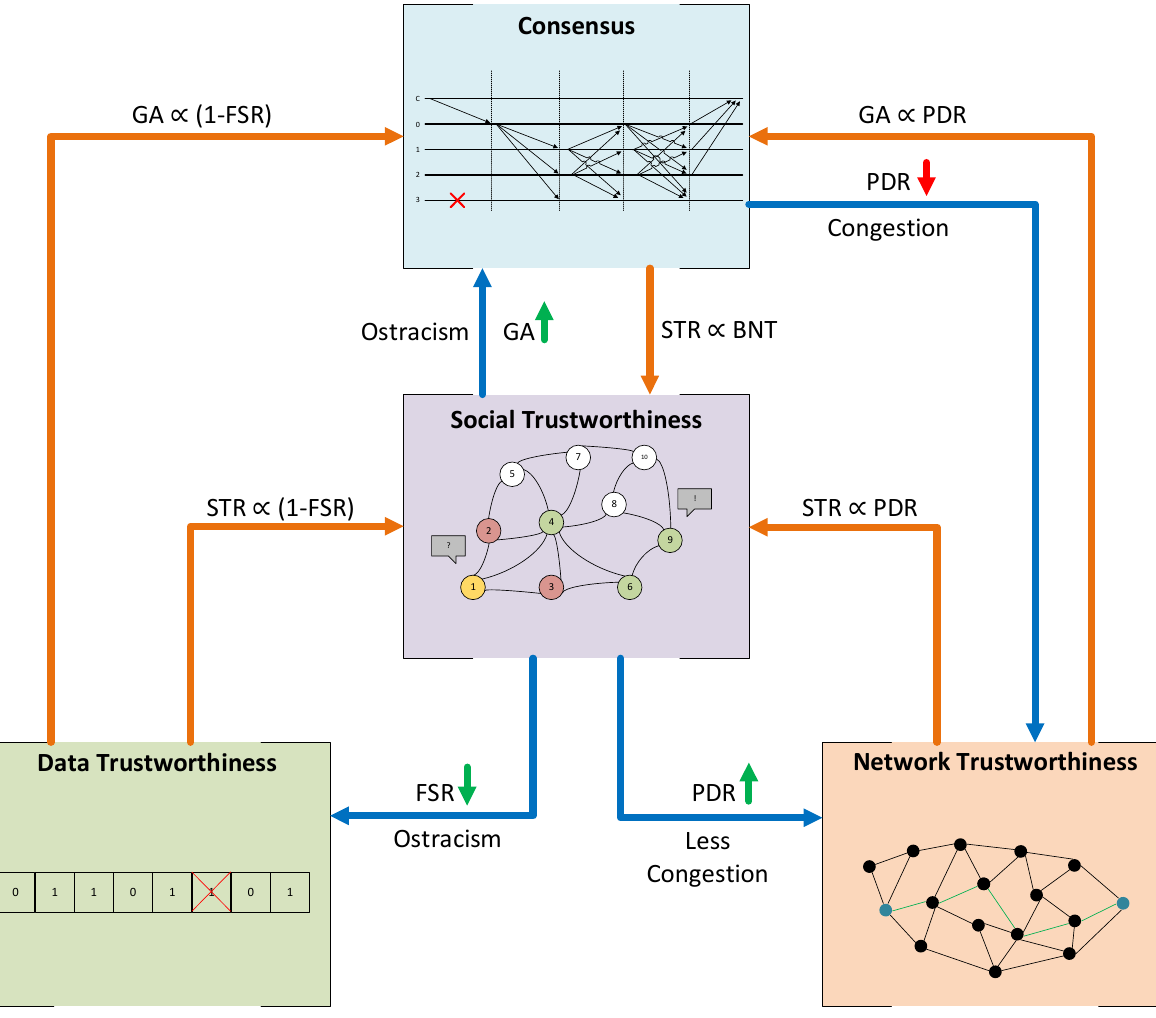
Figure 3. Dependency diagram between trustworthiness layers.